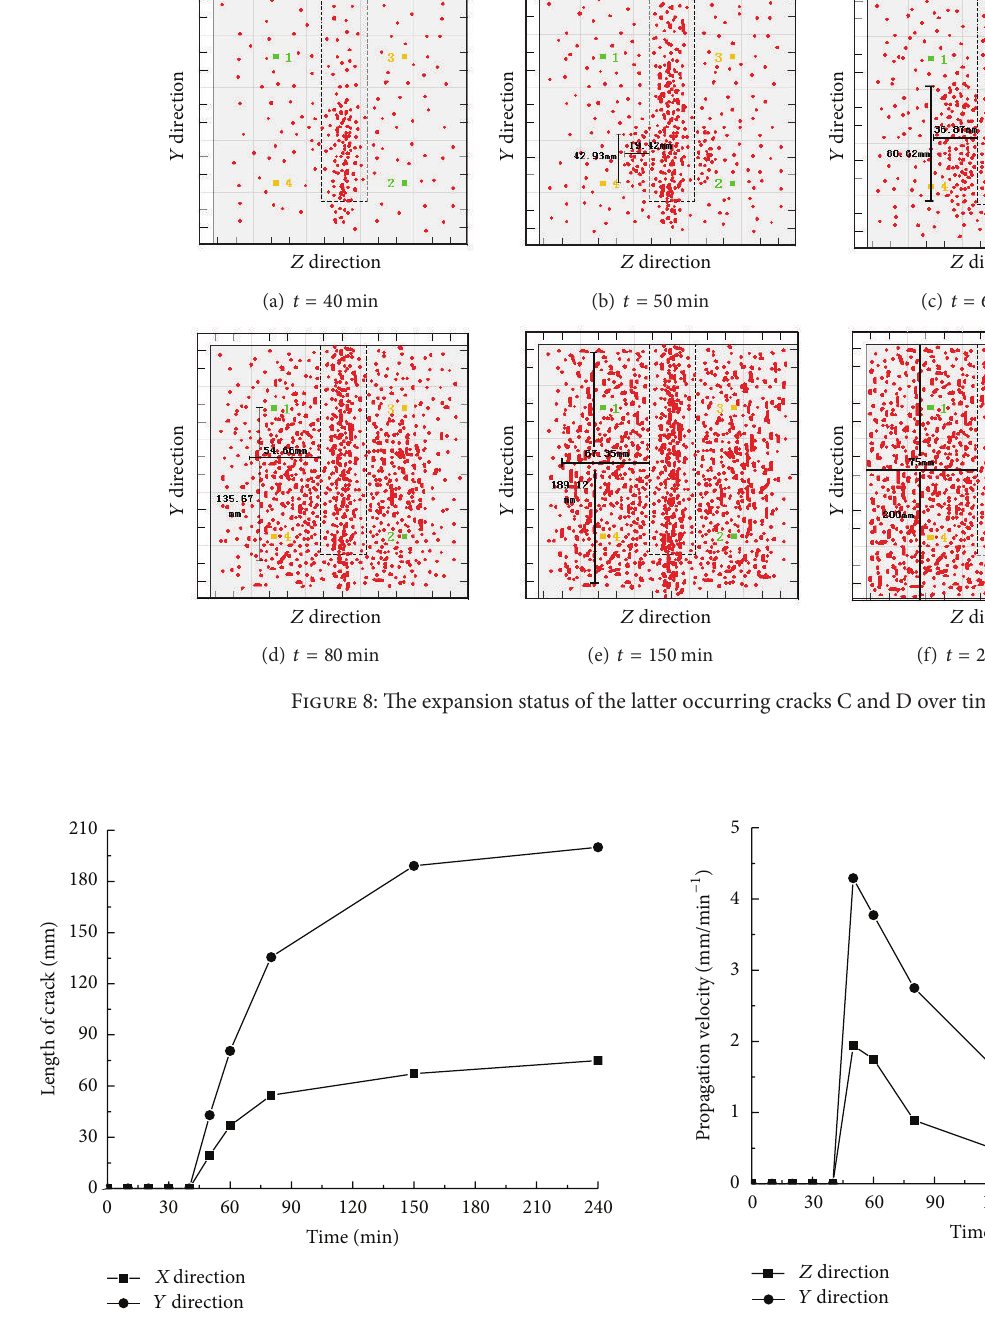
Figure 10: The relation curves between the average growth rate of C and D and